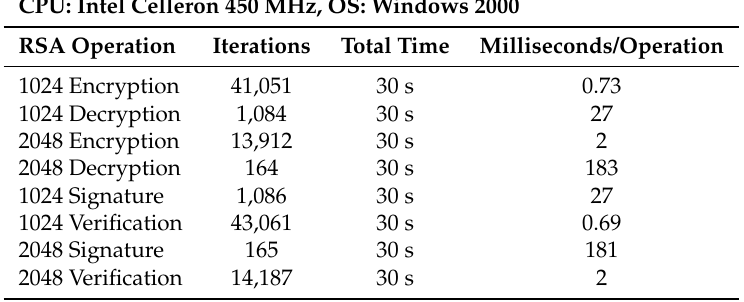
Table 3. The benchmark of Crypto++.